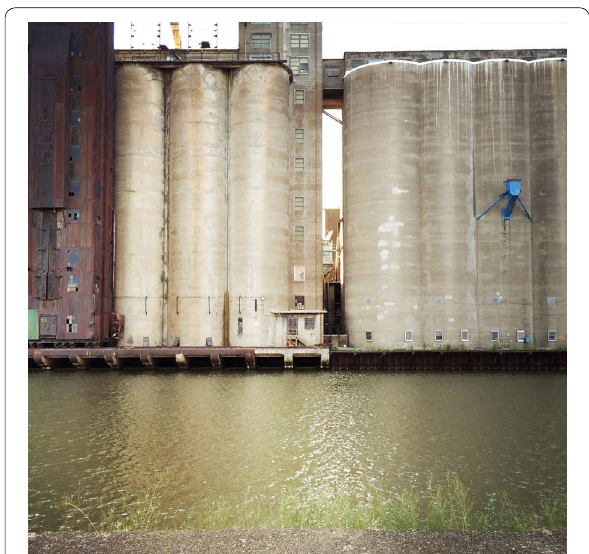
Fig. 6 Grain elevators. Silo City. Buffalo, New York (Photo by